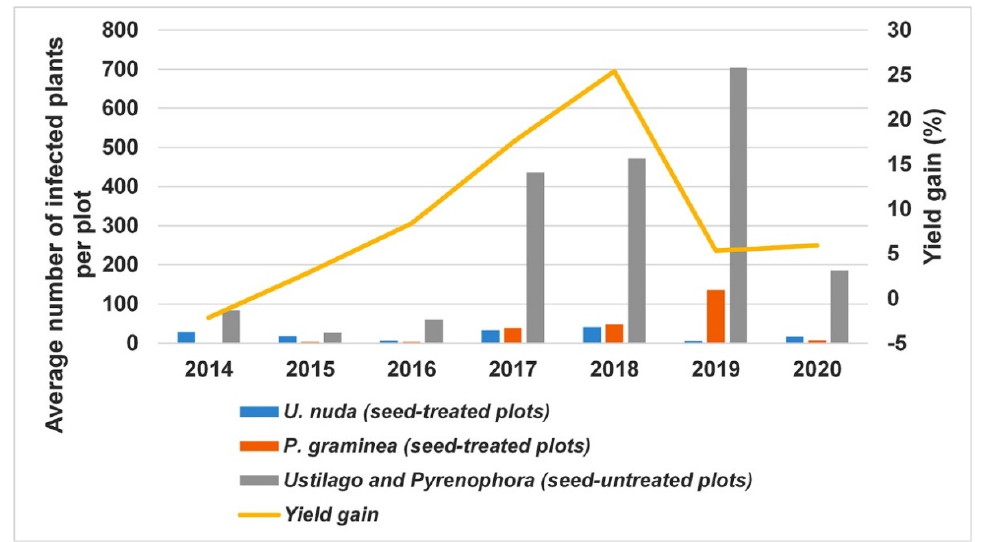
Figure 3. Relationship between U. nuda and P. graminea occurrence in seed-treated and seed-untreated plots and yield gain of variety Krajišnik in the period 2014–2020.